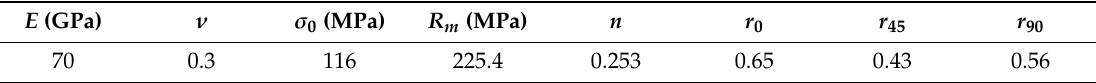
Table 2. Mechanical properties of 6014-T4 in the third month after solution treatment.